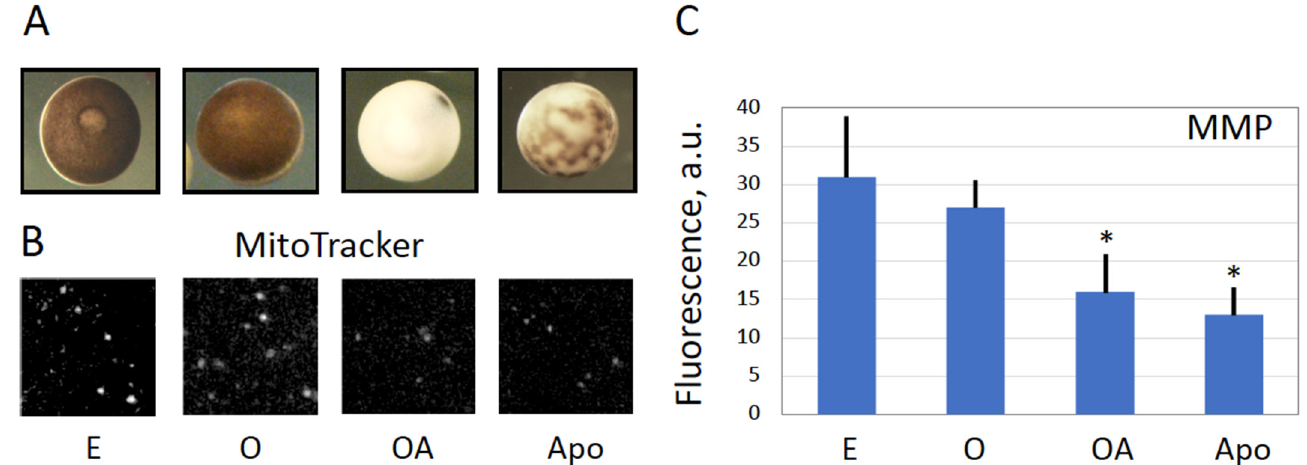
Figure 4. Decrease of the mitochondrial membrane potential in overactivated and apoptotic eggs. Morphological types of metaphase II-arrested (E), overactivated (OA), apoptotic (Apo) eggs and oocytes (O) are presented in panel ( A ). Corresponding fluorescent images of intracellular compartments, stained with the MitoTracker, are shown in panel ( B ). Panel ( C ) shows quantification of the data presented in panel ( B ). Fluorescent signals from more than ten individual mitochondria were evaluated in each cell type. Asterisks in panel ( C ) denote statistical difference ( p < 0.05) from untreated control eggs (E).